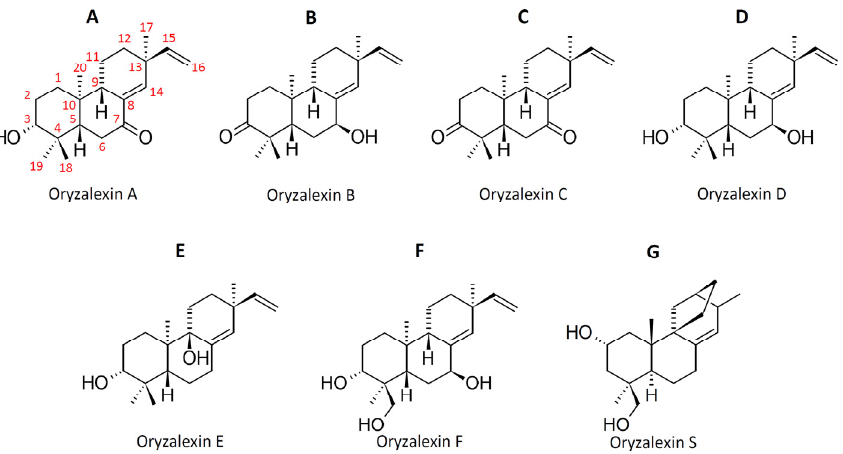
Figure 3. Oryzalexins so far isolated from rice. Despite the name, oryzalexins ( A – F ) are distinguished from oryzalexin S both by the chemical structure ( ent -sandaracopimaradiene- and stemarane-type, respectively) and by the metabolic intermediate from which they derive ( ent -sandaracopimara-8(14),15 diene and syn -stemar-13-ene, respectively; vide infra).